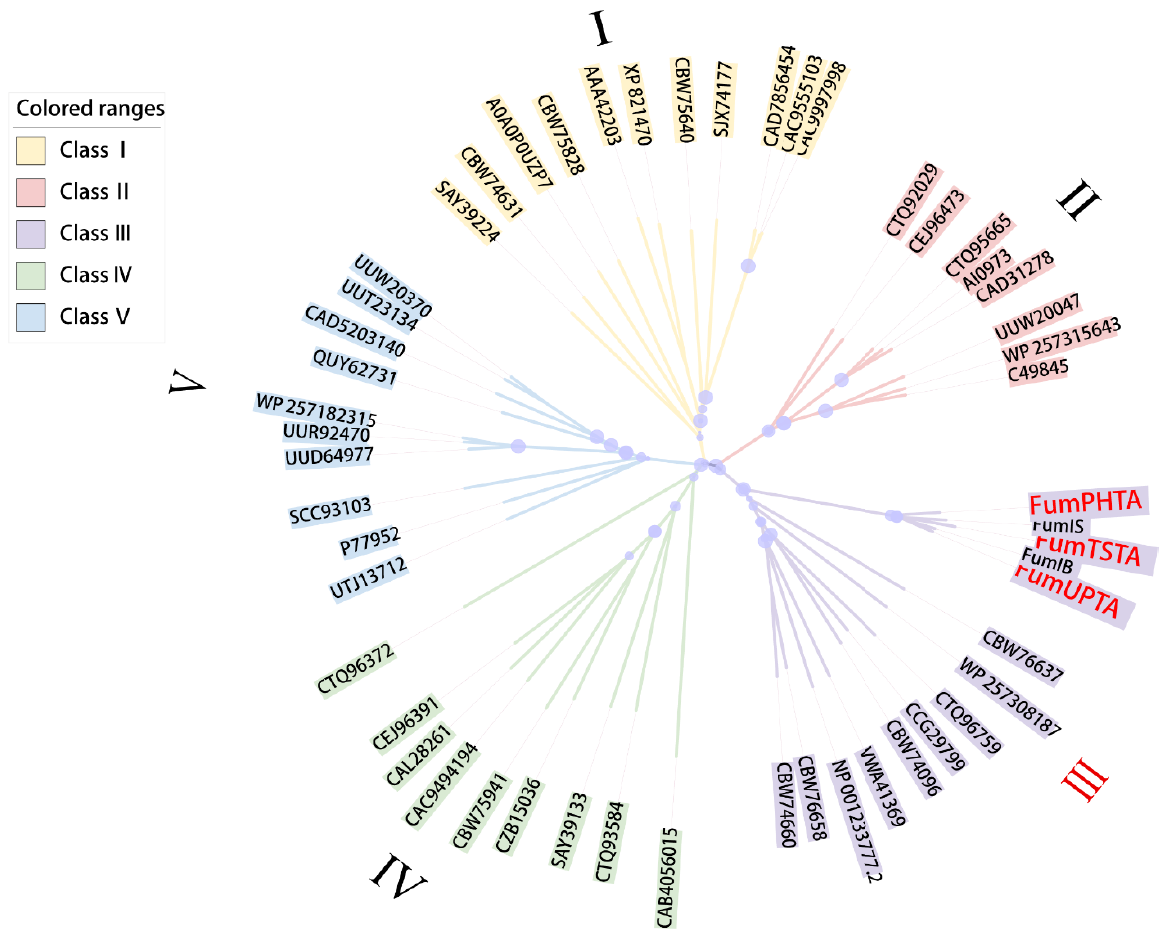
Figure 2. Establishment of a phylogenetic tree of fumonisin detoxification transaminases and other fold type transaminases sequences from five class. Branch lengths reflected the relative variation in amino acid sequences from each other. The light blue circle symbols were the bootstrap values of 1000 repetitions, the circle size was directly related to the number of bootstrap values. The corresponding family was shown. Three transaminases are highly marked in red letters.